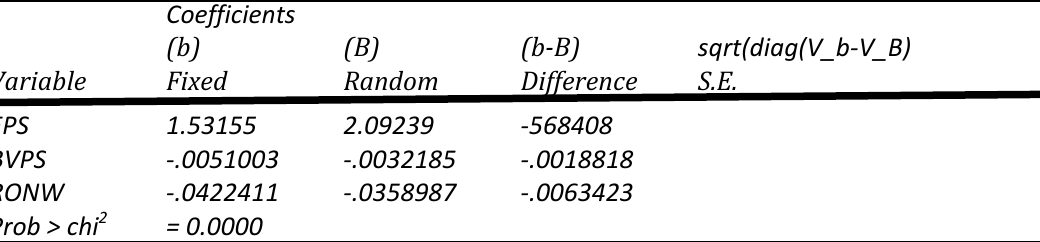
Table 4. Hausman